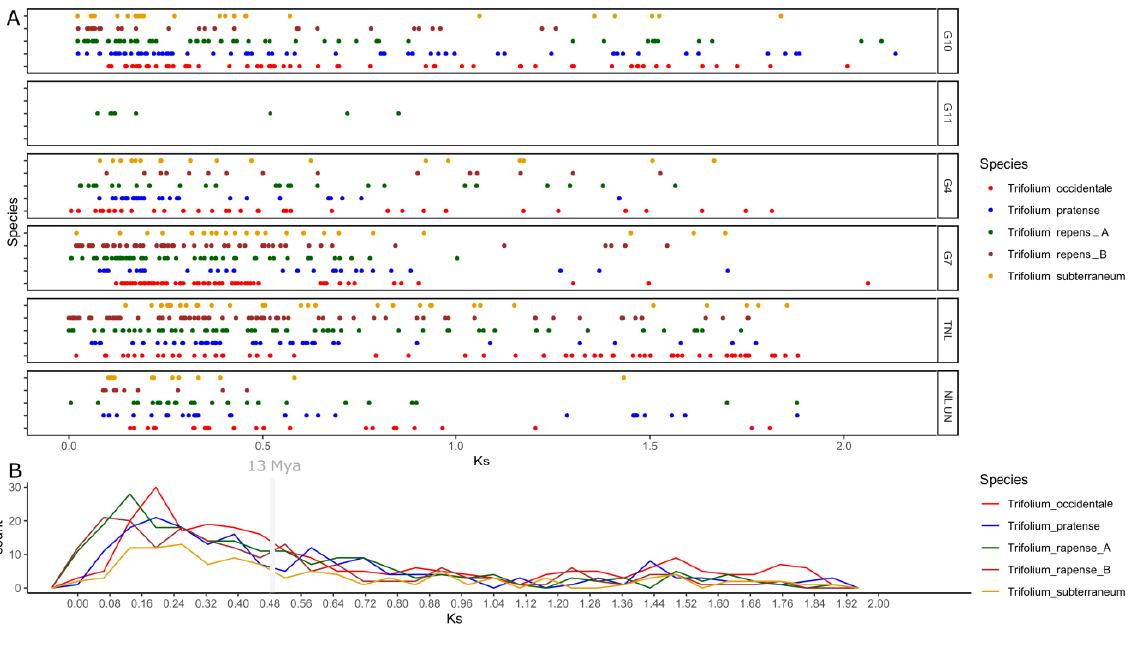
Figure 5. Estimation of NLRome duplication event in the genus Trifolium. All five species belonging to the genus Trifolium with Ka/Ks values of their paralogs are denoted. ( A ) The vertical axis indicate Ks value and horizontal axis shows frequencies. ( B ) The generalized observed duplication manner in all species.